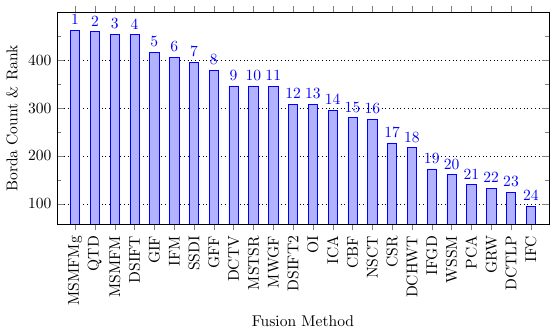
Figure 9. Borda count results on both dataset. The number at the column top shows its rank among the 24 compared